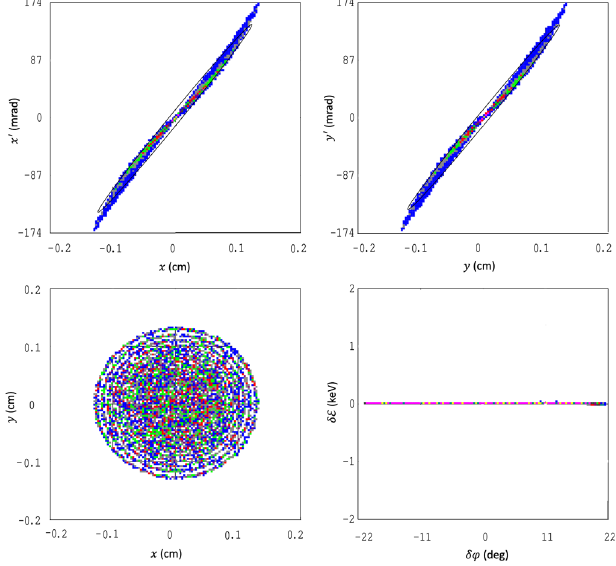
FIG. 22. Beam phase-space in the plane of the electric wall of the input aperture. The cathode is concave ; the emittance is 1 mm mrad.